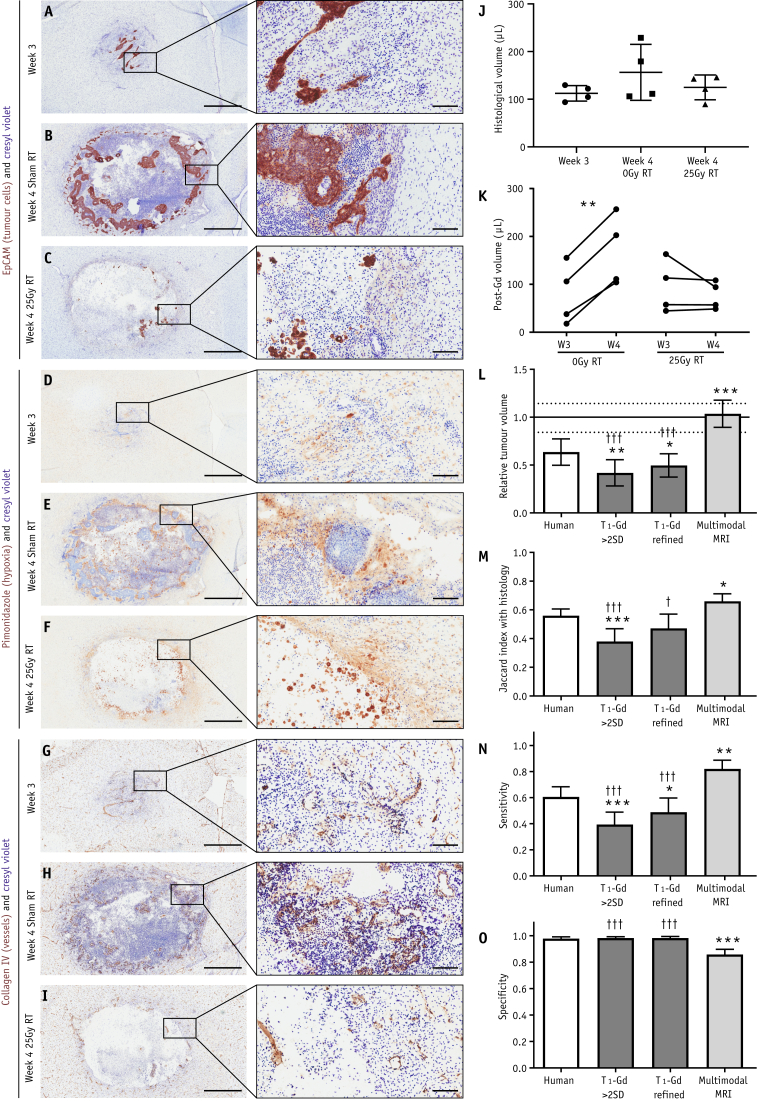
Tumor appearance, size, and detection by manual and automated methods. (A-I) Photomicrographs of tumor showing brown EpCAM staining (tumor; A-C), pimonidazole staining (hypoxia; D-G) or collagen IV staining (vessels; G-I), each with blue cresyl violet counterstain at week 3 (A, D, and G), week 4 after sham radiation therapy (RT; B, E, and H), and week 4 after 25 Gy radiation therapy (C, F, and I). Photomicrographs are from adjacent 20 μm sections from the same animals. Scale bars are 1 mm for widefield panels and 100 μm for magnified insets. (J) Histologic tumor volume in each animal. (K) Pre- and post-radiation therapy tumor volumes, as assessed by independent observation of post-Gd T1-weighted magnetic resonance imaging (MRI) data sets. (L) Tumor volume detected by each method relative to the mean histologic size within each of the 3 groups of animals; mean ± 95% confidence intervals (CI). Mean and 95% CI for histologic detection are solid and dashed horizontal lines, respectively; n = 12 in each group. (M) Jaccard indices between tumor maps produced by each of the 4 methods and histologic gold-standard tumor maps; n = 12 in each group. (N) Sensitivity and (O) specificity of each method for detecting voxels identified as tumor histologically; data are given as mean + 95% CI; n = 12 in each group. *P < .05, **P < .01, ***P < .001 relative to human observer; †P < .05, †††P < .001 relative to multimodal MRI, analysis of variance followed by Sidak multiple comparison test.